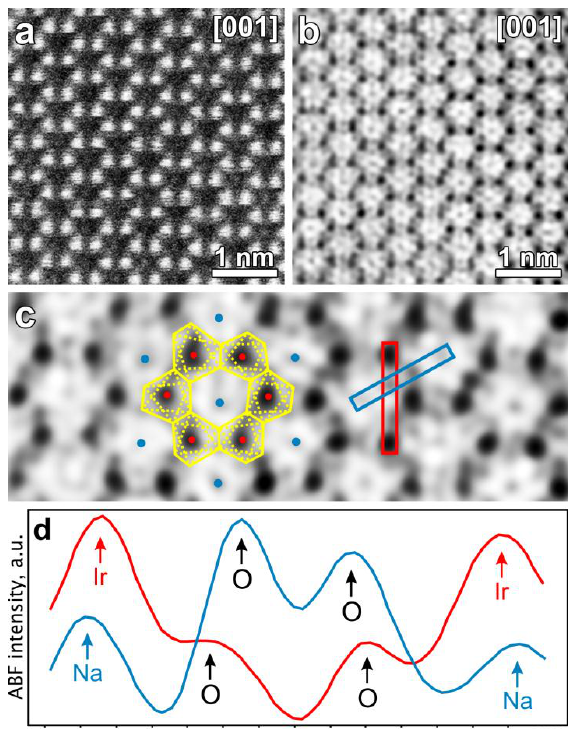
Figure 1. Complementary [001] HAADF-STEM ( a ) and ABF-STEM ( b ) images of fully-charged Na2-xIrO3 with an O1-type structure. Magnified fragment of the ABF-STEM image ( c ) with marked projections of the IrO6 octahedra (red dots: Ir columns; blue: Na; and yellow lines: O octahedral projections). Intensity profiles measured in the areas marked in blue and red highlighting short and long projected O−O distances ( d ). Adapted with permission from [33]. Copyright 2016 American Chemical Society.